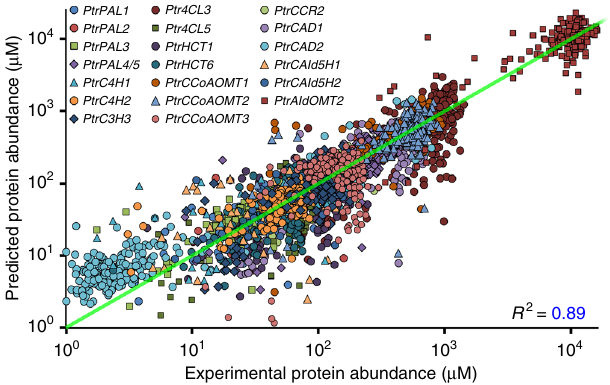
Fig. 4 Regression of monolignol transcript/protein relationships. Transcript abundance is used in the linear regression equations (Supplementary Table 2) to obtain the predicted protein abundance ( y -axis), which is regressed on the experimental protein abundance ( x -axis). The equations can explain ~89% of the variation in abundance of the monolignol biosynthetic proteins in the 239 transgenic and wildtype samples, based on the abundance of the gene transcripts. Each data point represents the abundance of a monolignol gene for a replicate pool of one wildtype or transgenic line containing 3 – 5 clonally propagated